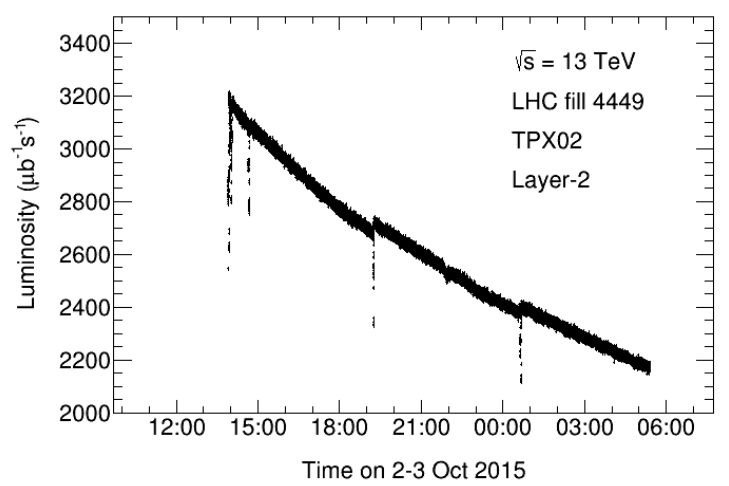
Figure 33. Time history of the TPX luminosity. The small dips, visible as variations from the descending curve, correspond to the times when the LHC operators performed small-amplitude beam-separation scans to optimize the luminosity. The normalization between hit rate and luminosity is based on vdM scans using LHC fill 4266, as detailed in Section 5.2. Taken from Ref.